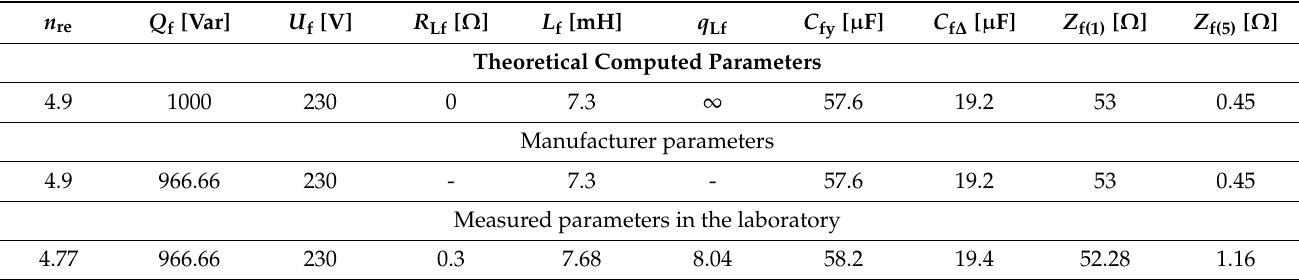
Table 5. Summarized single-tuned filter parameters (one phase).